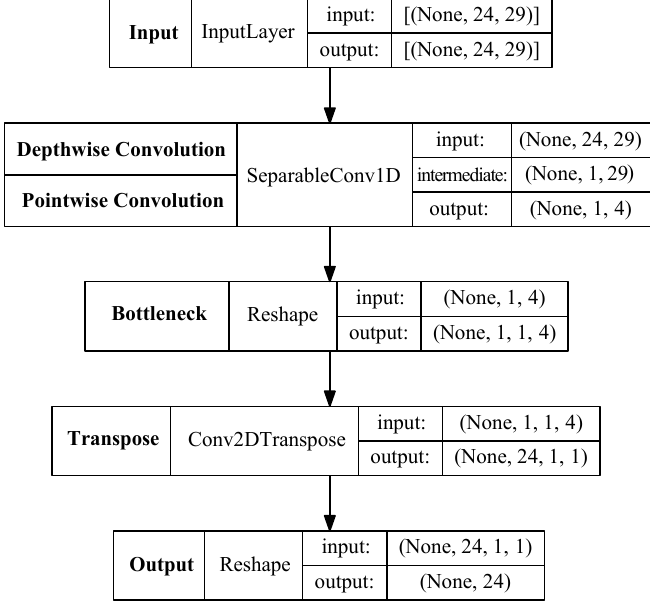
Figure 6. Structure of the convolutional autoencoder used to extract the features from the